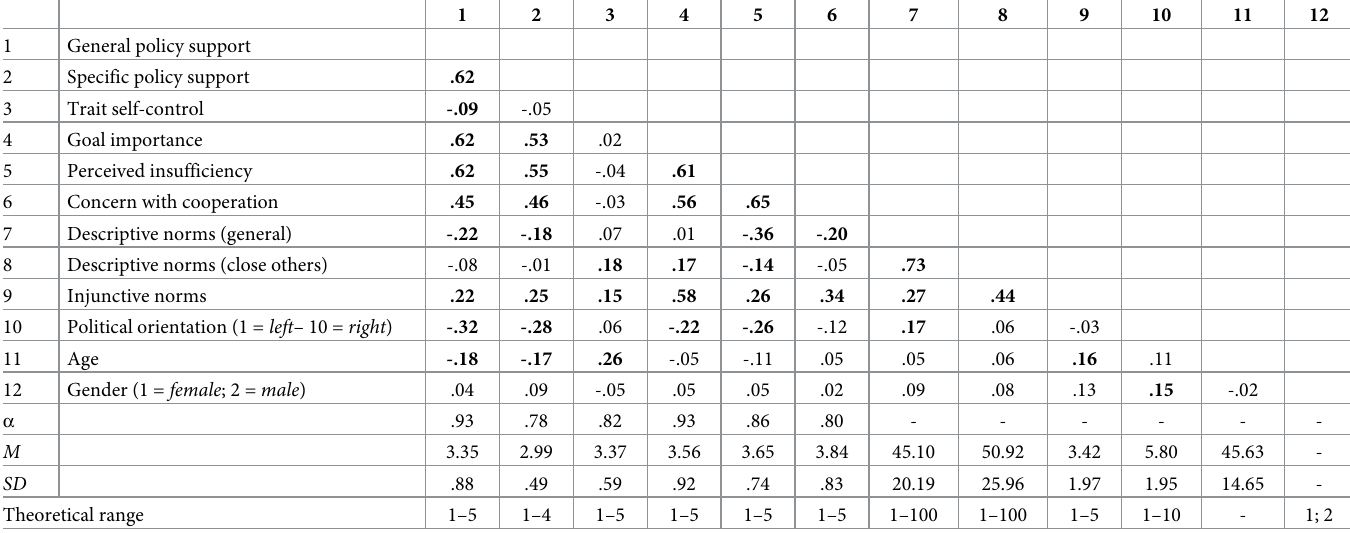
Table 3. Summary of intercorrelations, internal consistencies, means, and standard deviations for main study